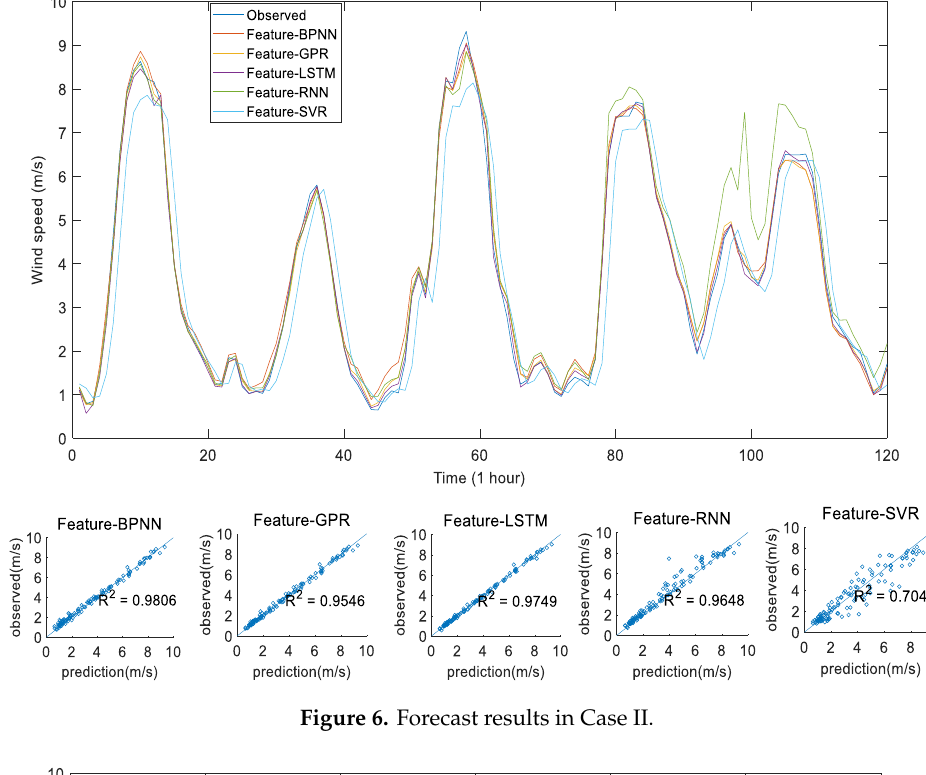
Figure 6. Forecast results in Case II.